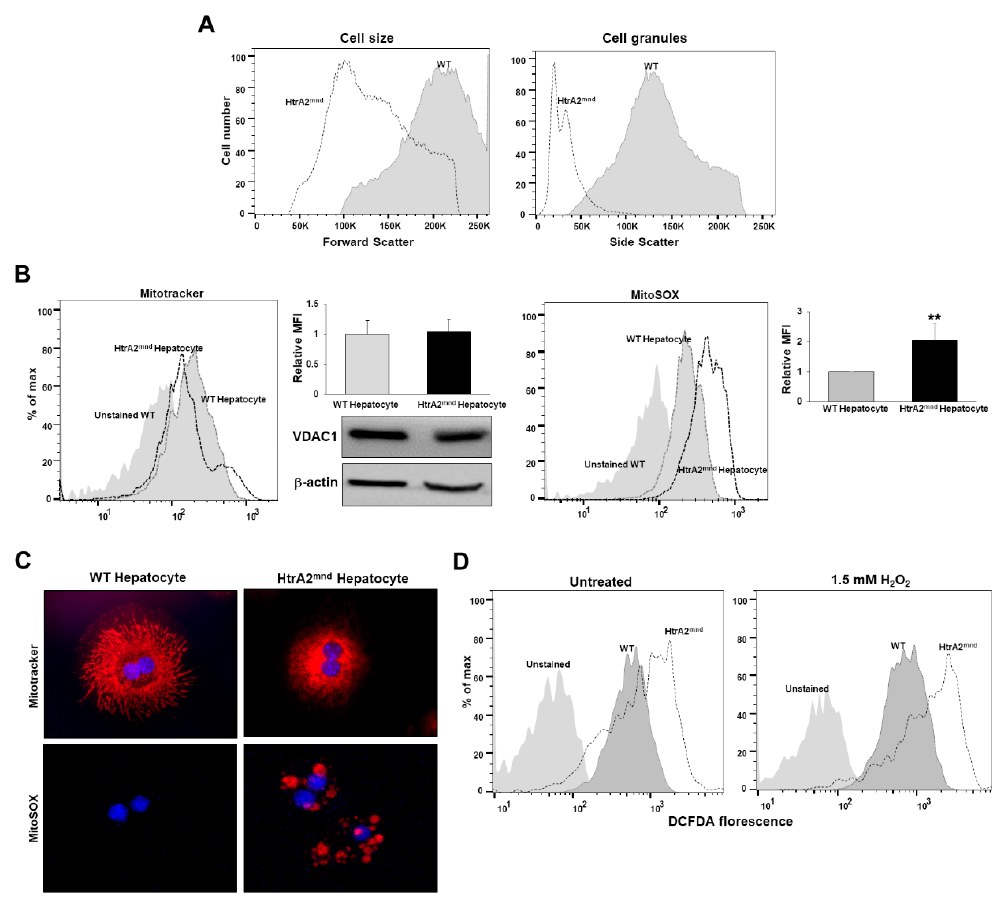
Figure 4. Loss of HtrA2 / Omi in hepatocyte results in the accumulation of dysfunctional mitochondria and oxidative stress. ( A ) Exemplary flow cytometry plot and histogram of showing populations of primary hepatocyte in light scatters. ( B ) Mitochondrial morphology and superoxide levels in isolated hepatocyte were measured by FACS-analysis using MitoTracker green and MitoSOX red staining. The fluorescence mean intensity per cell was quantified. Western blotting for VDAC, mitochondrial mass proteins in WT and mnd2-mutant hepatocytes, with β -actin as a loading control. ( C ) Confocal microscopy of Mitotracker and MitoSOX red staining in primary hepatocyte. Nuclei were stained blue by DAPI. ( D ) Intracellular ROS levels in primary hepatocyte were measured by FACS-analysis using CM-H 2 DCFDA staining.